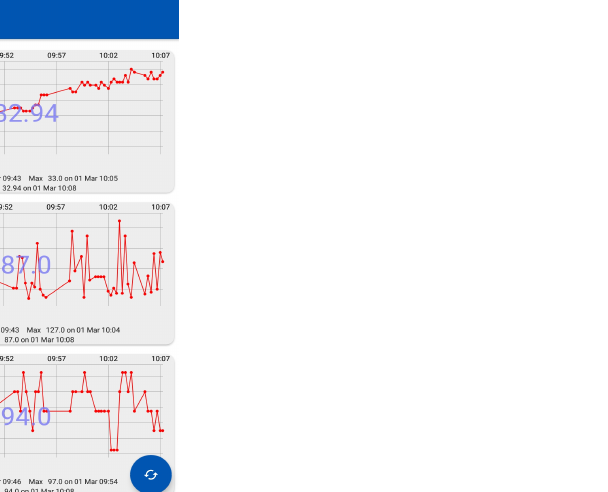
Figure 17. Vital Sign Monitoring Using Mobile App—Top figure shows the body temperature data, the middle shows the heart rate data, and the bottom figure shows SpO 2